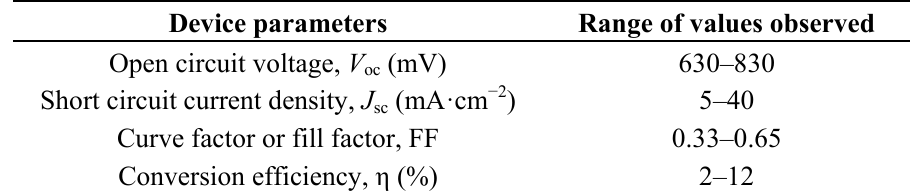
Table 2. Typical solar cell parameter ranges observed for CdS/CdTe structures with electroplated materials under AM1.5